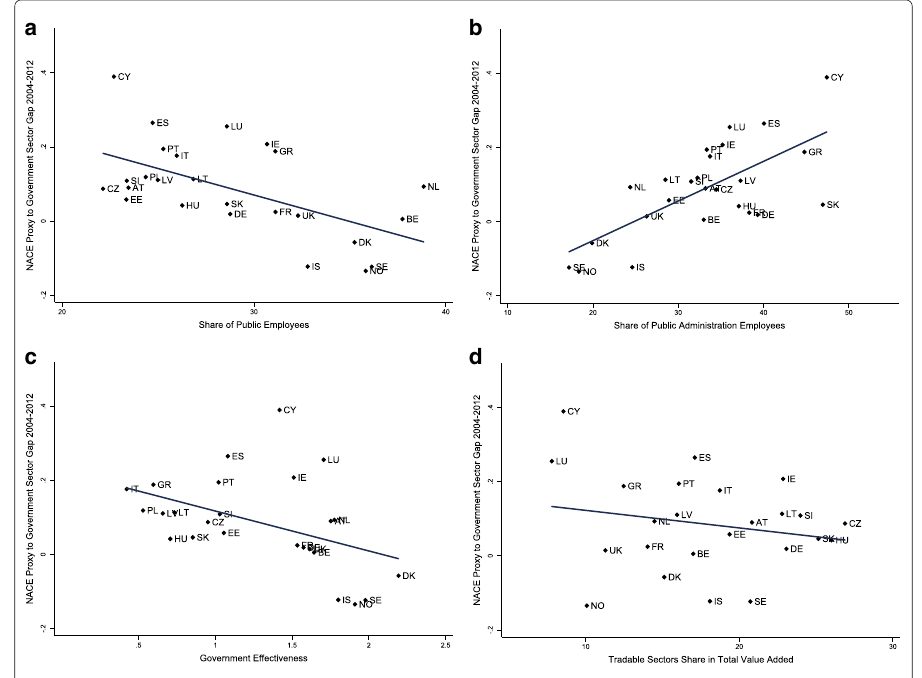
Fig. 2 a – d The monopolistic power of governments and the wage gap: bivariate relationships. Notes: This figure shows the scatterplots of the variables capturing the monopolistic power of governments with the public sector conditional pay gap. The pay gap is estimated from micro data for the period 2004–2012; see Table 1. Panels a to d show the correlation between the wage gap and the share of public employees, the ratio of Public Administration Employees (over public employees), the government effectiveness and the share of tradable sectors in total value added,